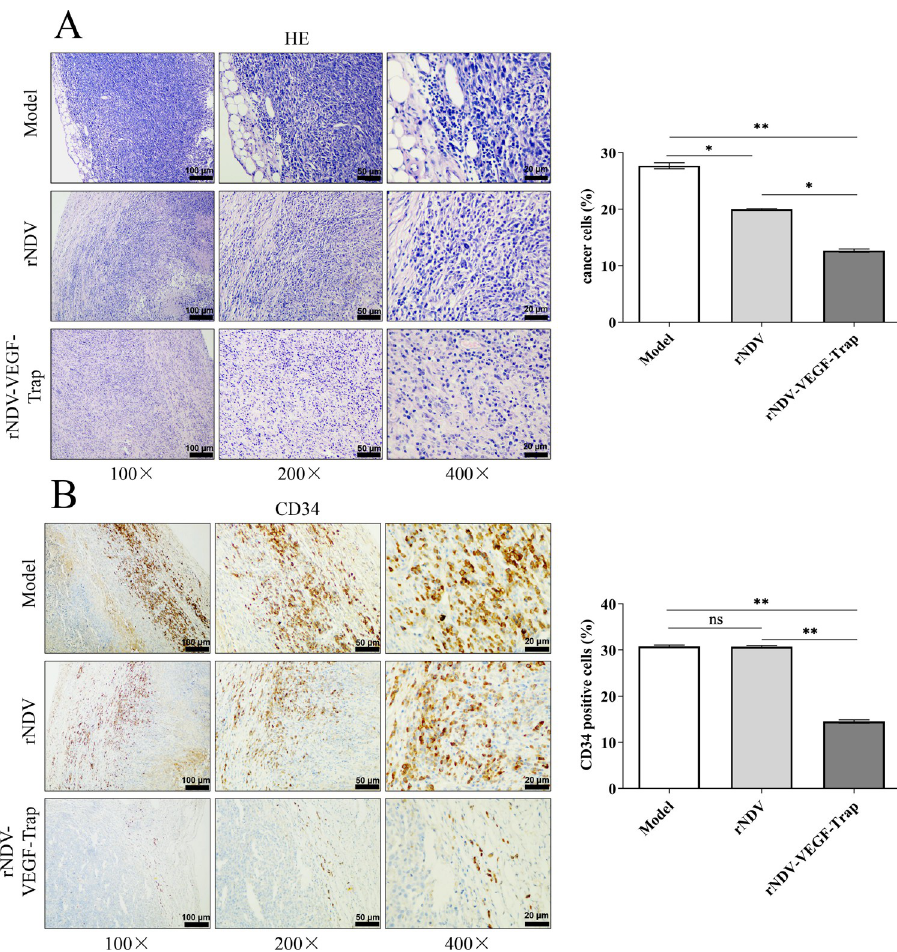
Fig 4. rNDV-VEGF-Trap enhances oncolytic effect in CT26 model. Six-week-old female BALB/c mice were injected with 10 6 CT26 cells in the right groin. When the tumor size reached about 100 mm 3 , the mice were intratumorally injected with rNDV or rNDV-VEGF-Trap at 10 7 pfu. The mice were euthanized and necropsy was performed after 15 days of treatment. (A) H&E staining of CT26 tumor section after treatment. (B) CD34 in the tumor tissues were visualized by IHC assay. The proliferation of vascular endothelial cells were shown in brown. Model: mice treated with allantoic fluid. N = 3. Magnification: 100 × , 200 × , 400 ×